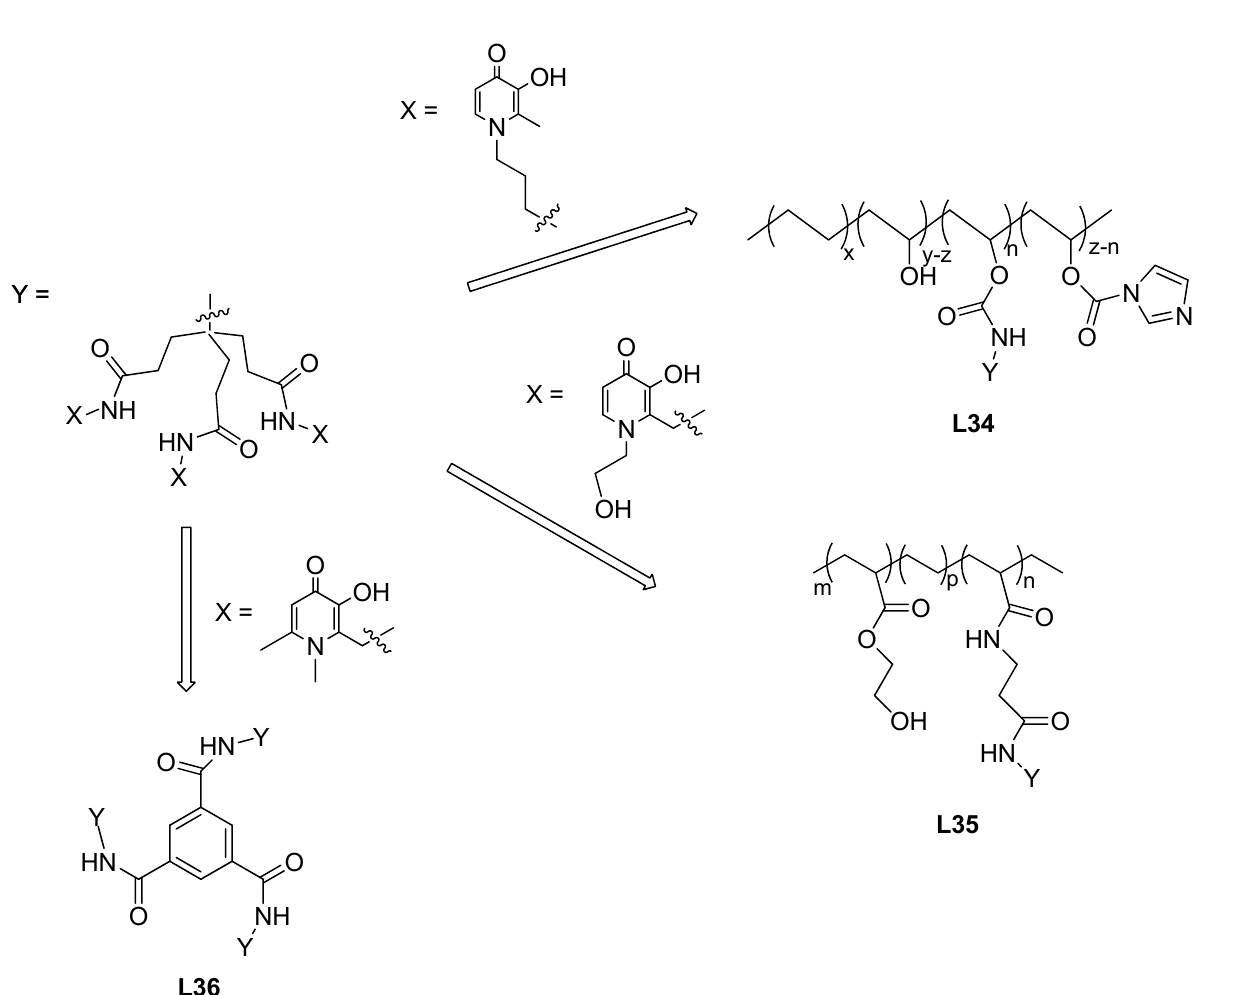
Figure 9. Schematic structure of (tris-3,4-HP)-containing copolymers ( L34 , L35 ) and dendrimer ( L36